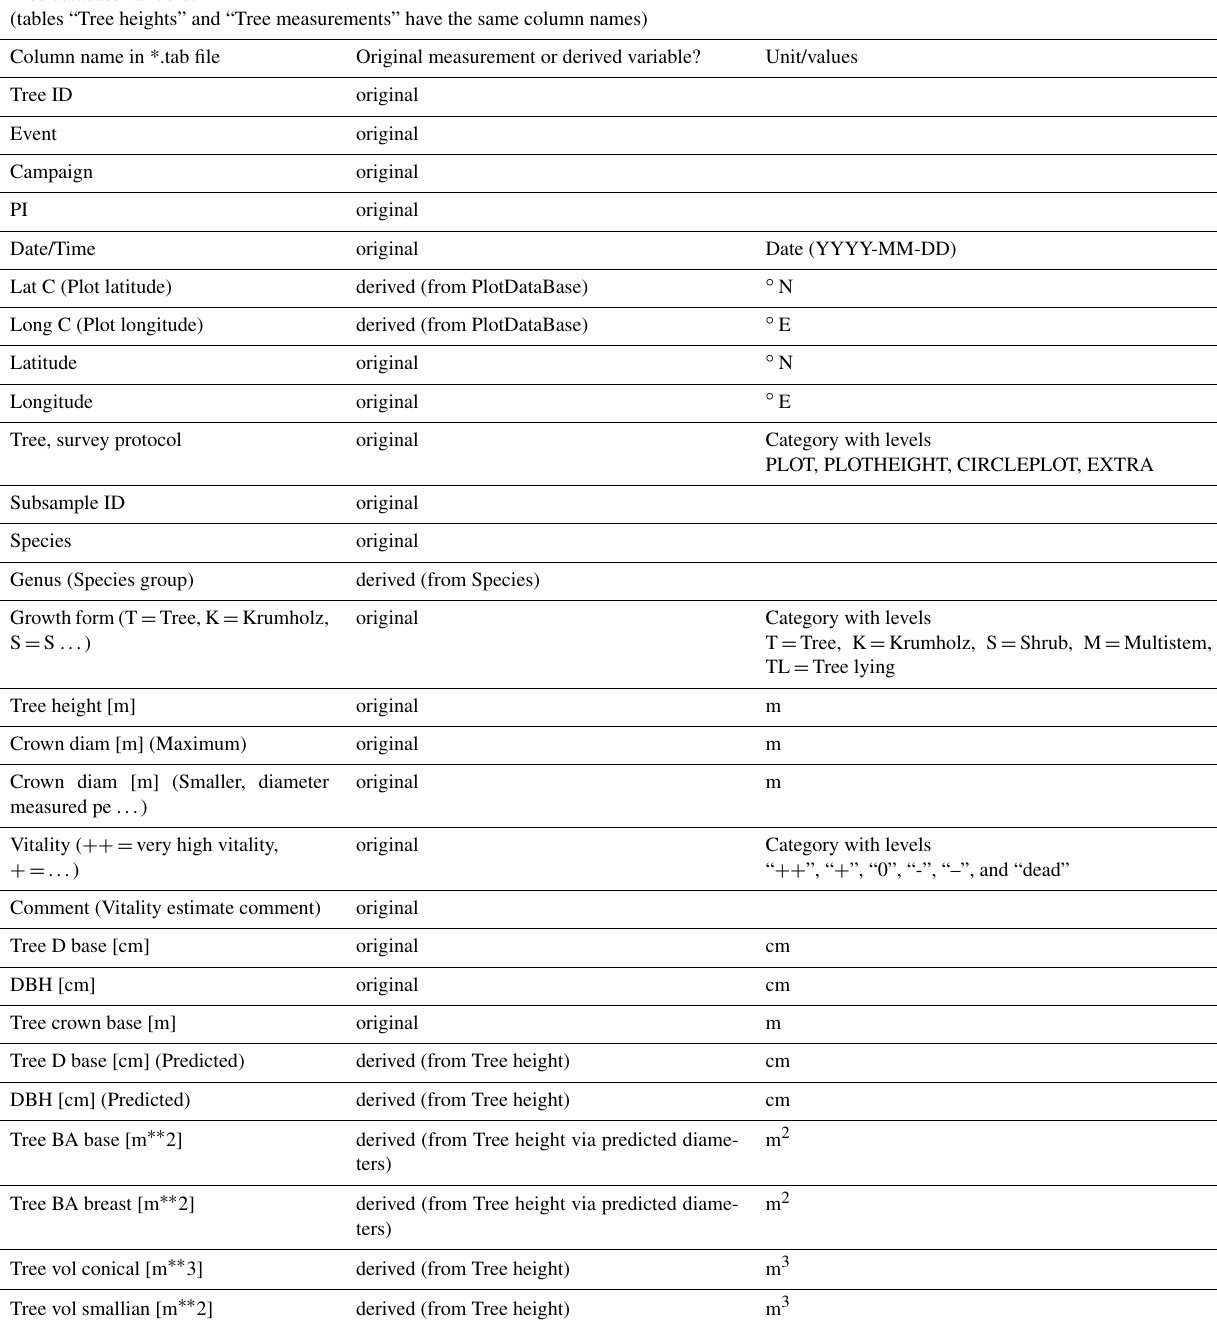
Table B1. List of all variables of the tree database. The spelling, capitalization, grammar and units reflect the original database. Tree database variables (tables “Tree heights” and “Tree measurements” have the same column